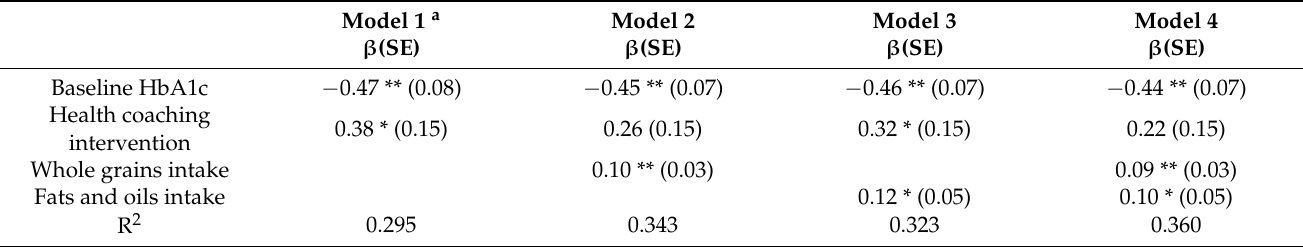
Table 3. Multiple linear regression analysis between health coaching intervention, healthy diet behavior, and